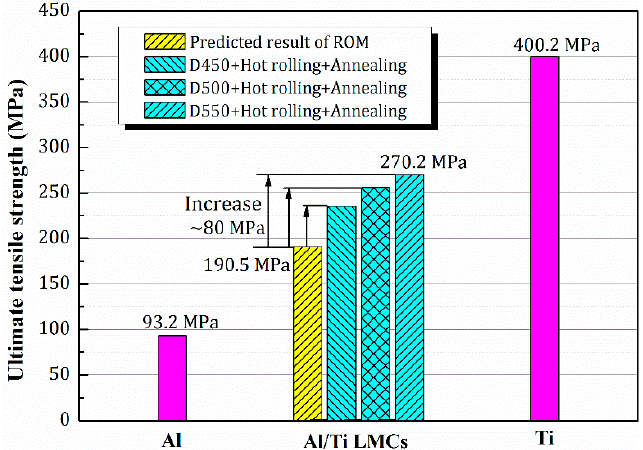
Figure 11. Comparison of the ultimate tensile strength (UTS) of Al / Ti LMCs and the predicted strength based on the ROM (rule of mixture).